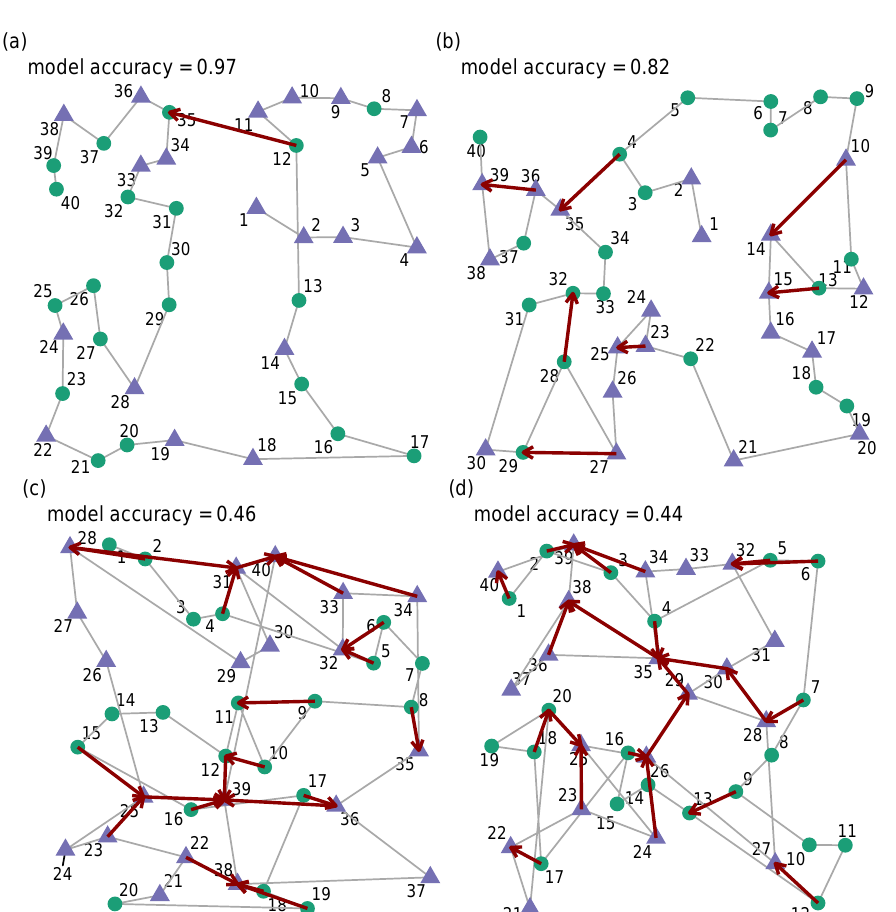
Figure 3. ( a , b ) Two randomly selected trials in which the model does a good job in accounting for human behaviour. The numbers indicate the order the participant selected targets in. Red arrows indicate places where the model prediction deviates from participant behaviour. When participants diverge from the model’s prediction, it appears to be due to some form of path-length optimisation. ( c , d ) Two randomly selected examples in which the model does a less good job in accounting for the order in which human participants selected the items.